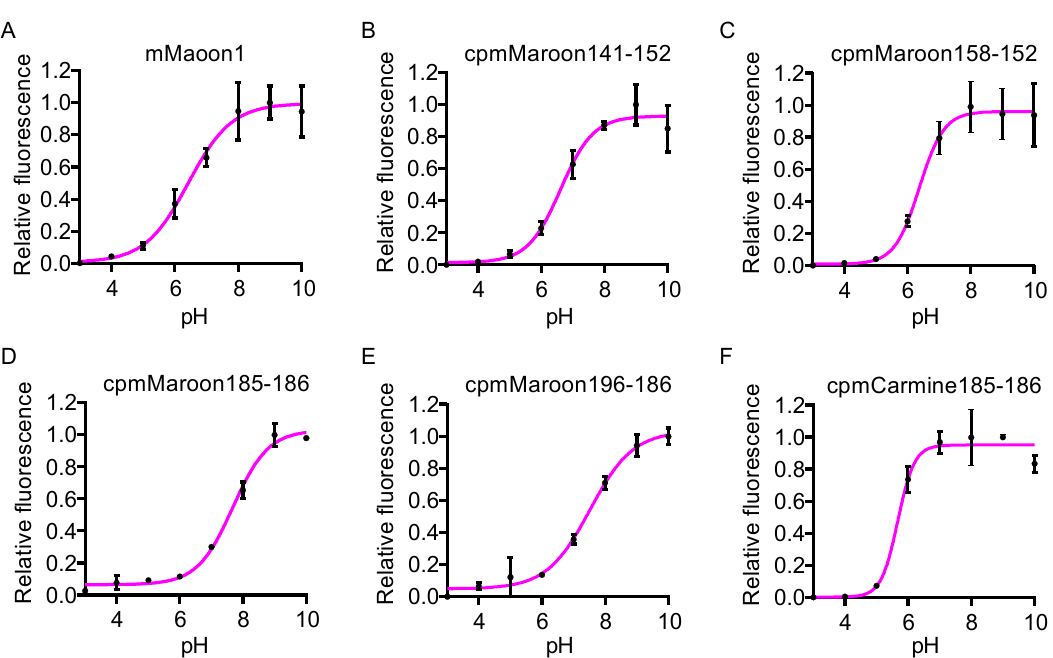
Figure 6. pH dependency of the fluorescence of different variants. Data are presented as mean ± s.d. of three technical replicates. Magenta lines are the fitting of the data with the Hill equation, and apparent p K a values (defined as the pH causing 50% of the overall fluorescence intensity change) are derived and presented in Table 1.